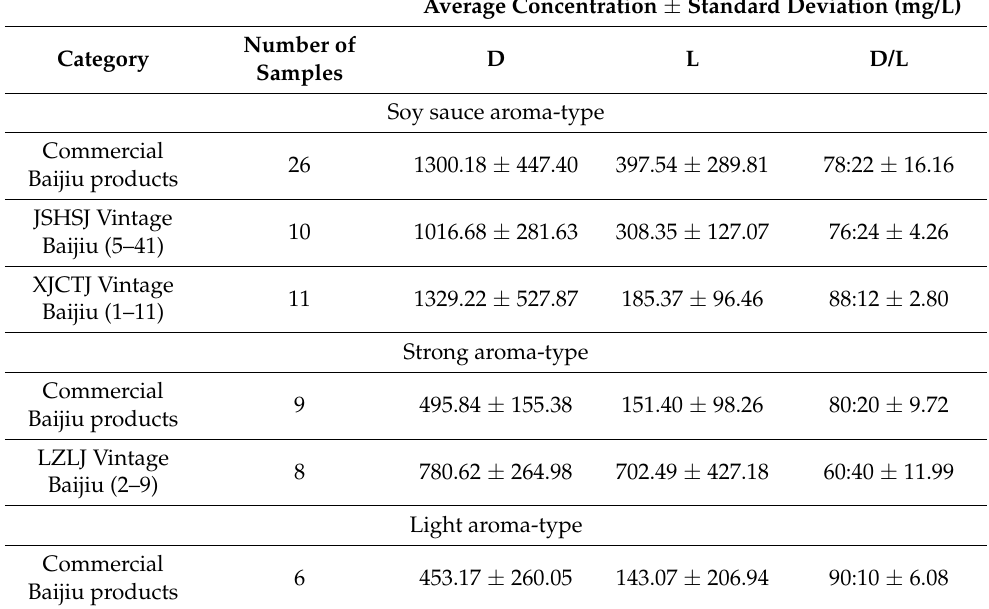
Table 3. Mean concentration and proportion of lactic acid isomers in different aromatic Baijiu. Average Concentration ± Standard Deviation (mg/L)